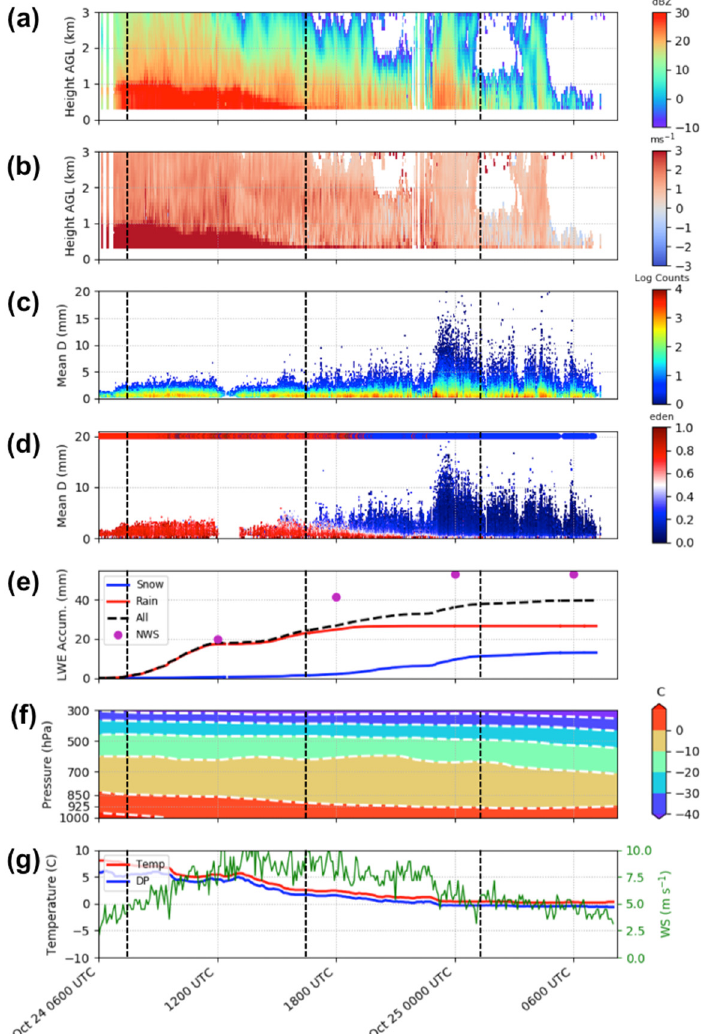
Figure 9. Observations during the 24 to 25 October 2017 event rain-to-snow transition event. Shown are MRR reflectivity ( a ) and Doppler velocity ( b ), PIP PSDs ( c ) and density estimates ( d ), Parsivel hydrometeor identification (d, red and blue dots on the upper portion of the panel), PIP and NWS LWE accumulation ( e ), ERA temperature profiles (red >0 °C) ( f ), and surface temperature, dew point, and winds ( g ). The dashed lines indicate time periods examined in the next figure. Radar reflectivities and Doppler velocities increase appreciably in the lowest 1 km AGL at the beginning of the event, indicating the melting level of the precipitation (Figure